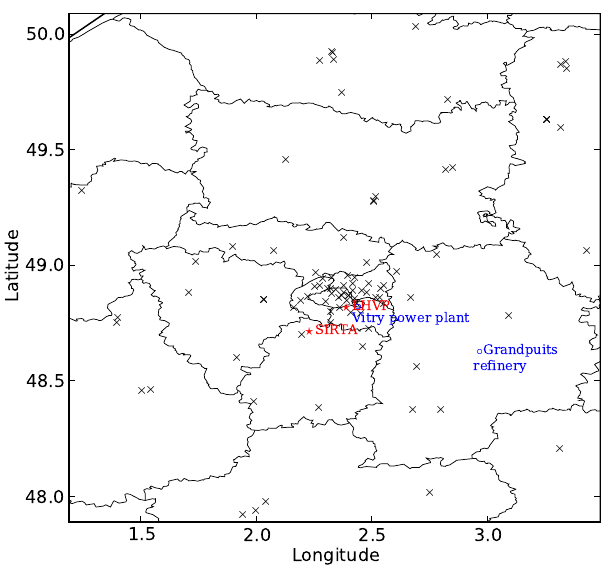
Fig. 1. Domain for the Greater Paris simulation with the locations of the two industrial sources selected for the PinG treatment (blue cir- cles), the stations of the BDQA monitoring network (black crosses), and the stations operated during the Megapoli campaign (red